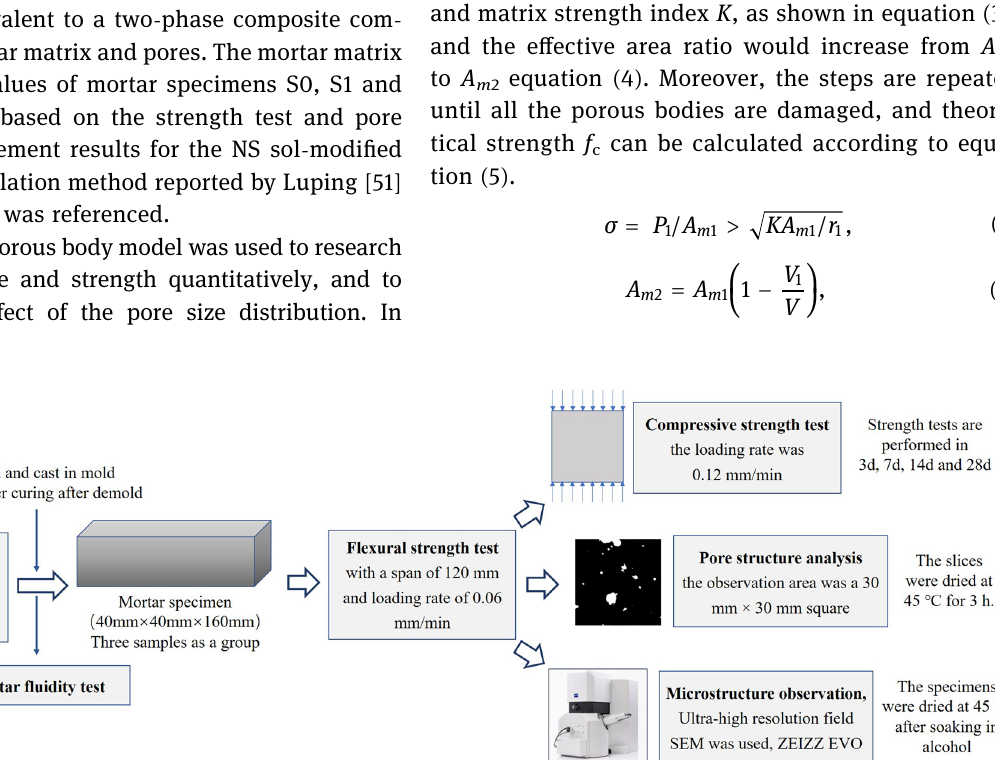
Figure 4: General overview of the experimental